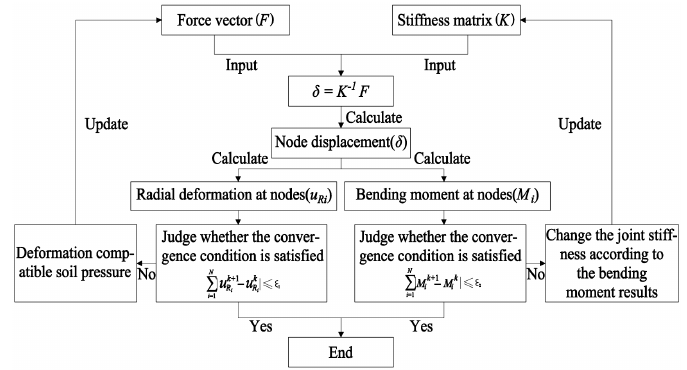
Figure 7. Program calculation flow chart.